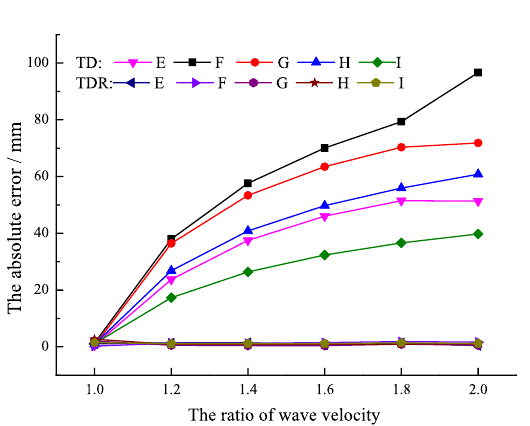
Figure 12. The absolute errors of the two algorithms.